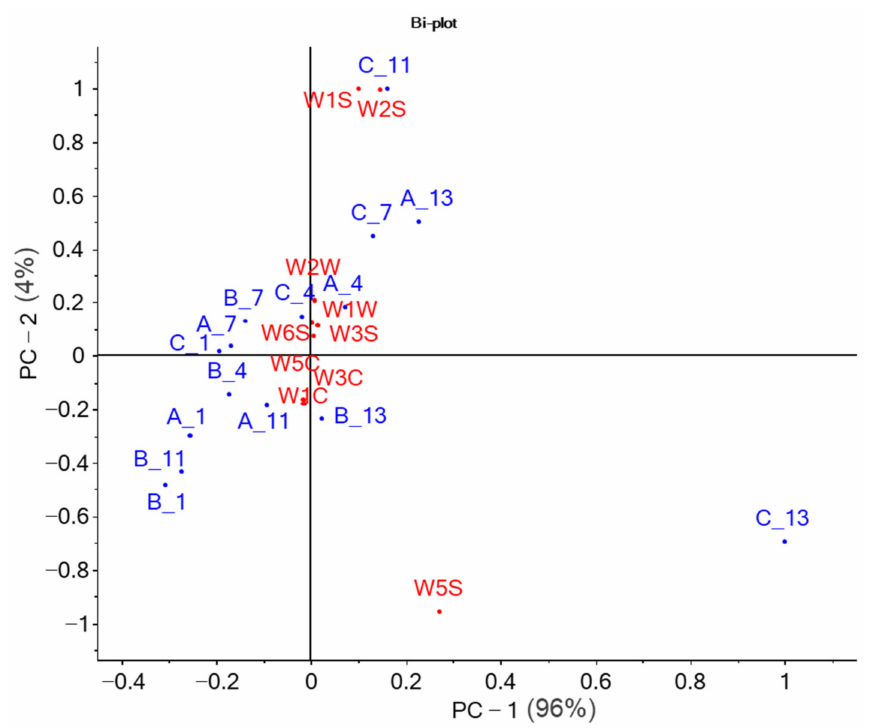
Figure 1. Biplot of E-nose sensor responses and samples scores (average values) during the storage of rocket